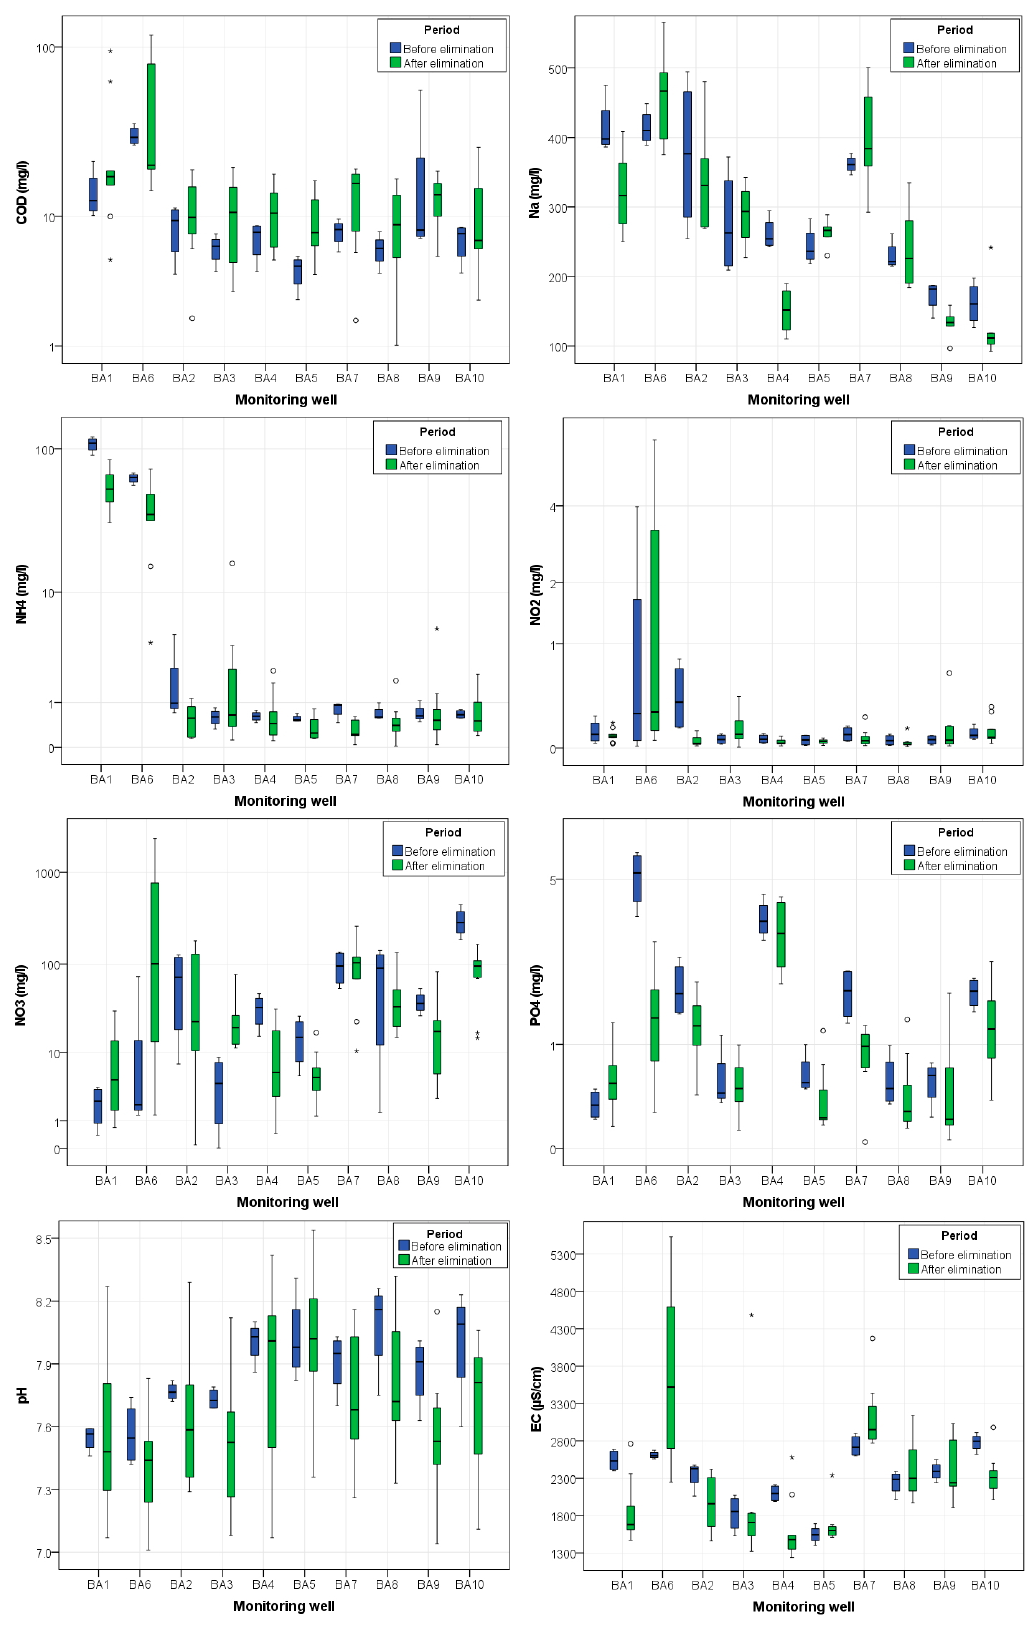
Figure 5. Temporal changes in water quality parameters in the monitoring wells, before and after elimination of the septic tank.